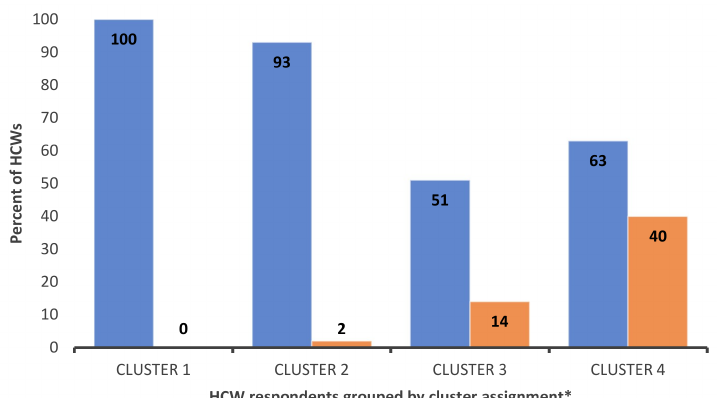
Figure 2. HCWs willingness to receive COVID-19 vaccine versus willingness to recommend vaccine to others. Blue: HCWs that probably or definitely would NOT receive COVID-19 vaccine; Orange: HCWs that probably or definitely WOULD recommend COVID-19 vaccine to others; * Cluster derivation and definitions are provided in surrounding